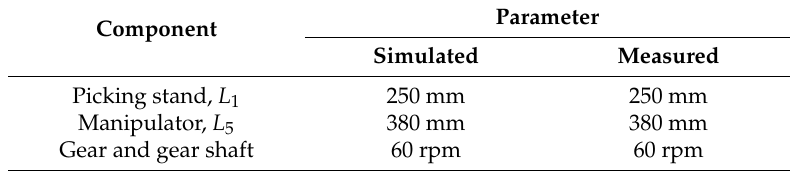
Table 4. Parameters of the picking device components to validate the kinematic analysis